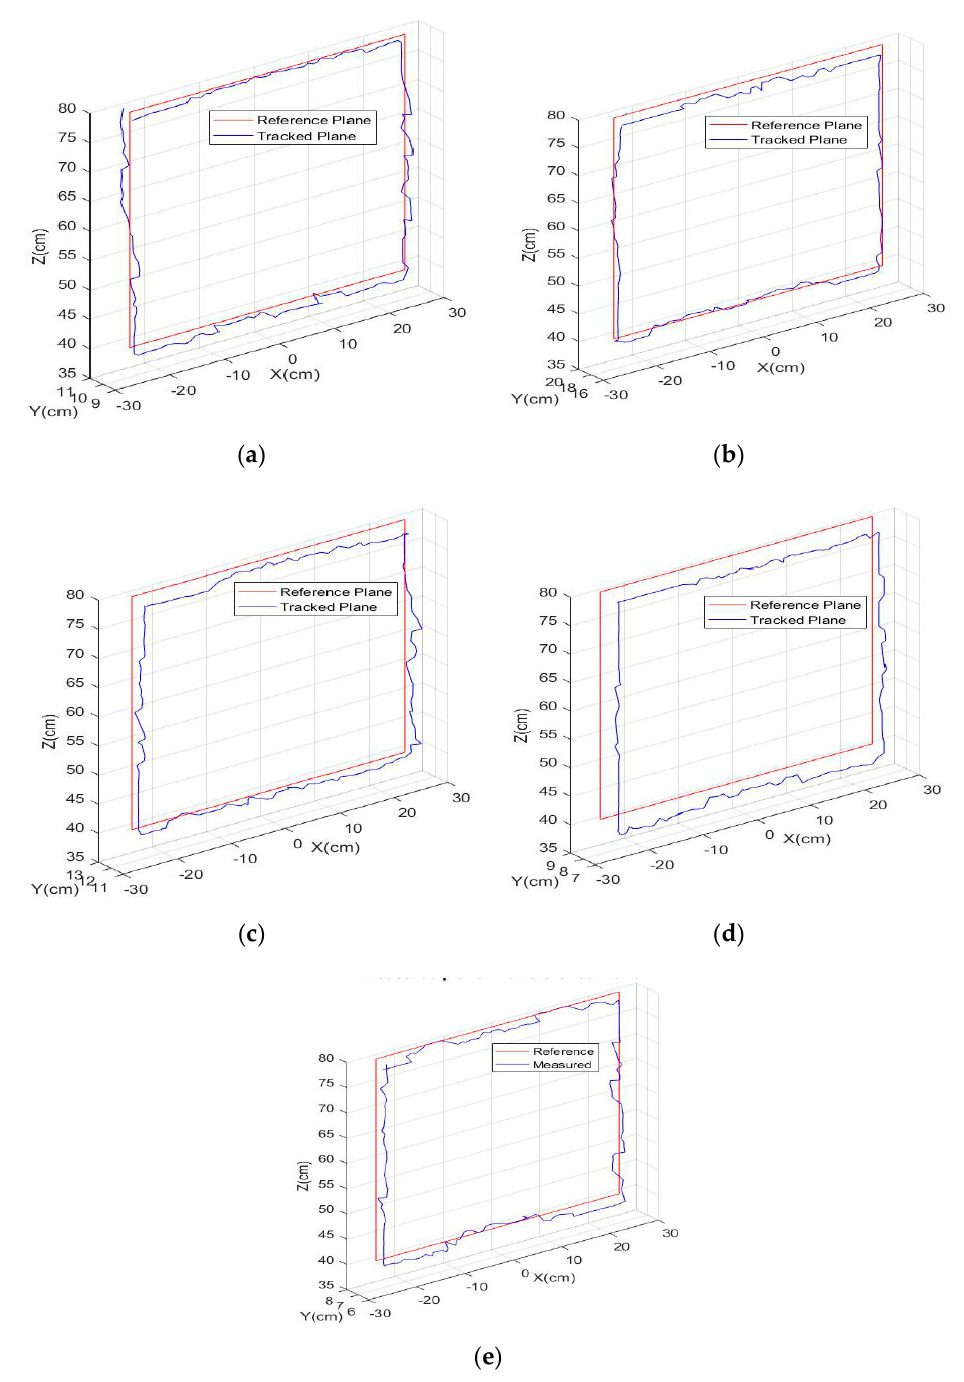
Figure 10. ( a ) LP ; ( b ) UP 1; ( c ) UP 2; ( d ) M ; ( e ) T . Tracked plane with respect to the reference plane for all LED positions.